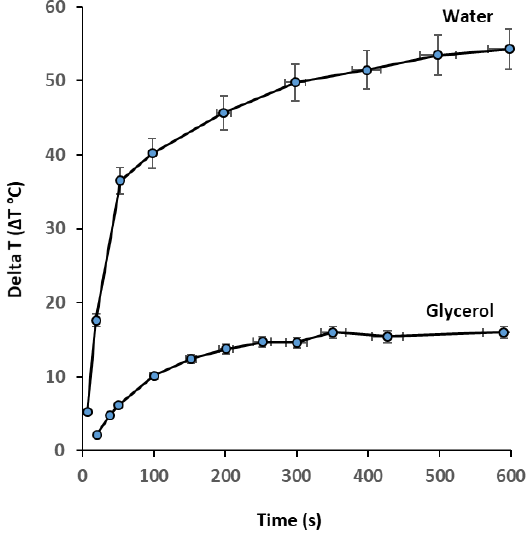
Figure 10. Heating profile of ZCF dispersed in water and glycerol at a concentration of 8 mg / mL, a magnetic field strength of 50 KA / m, and a frequency of 97 kHz.